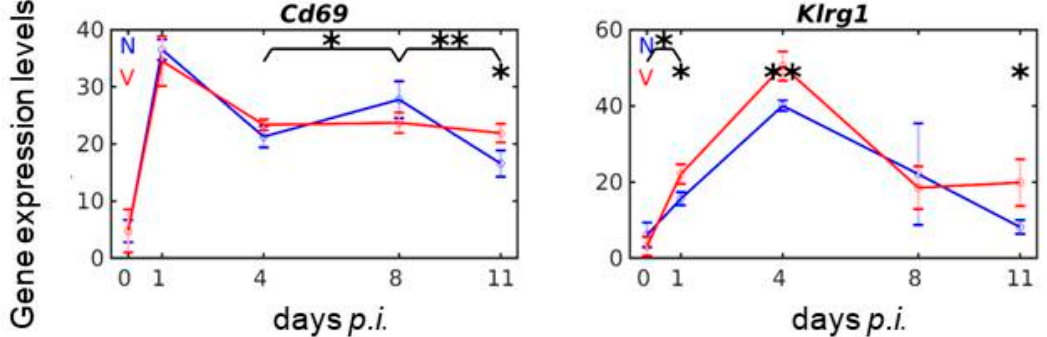
Figure 7. Expression trajectories of Cd69 and Klrg1 in the liver of vaccination-protected and non-protected mice. RNA was isolated from individual livers prepared from vaccination-protected (V, red) and non-vaccinated (N, blue) mice infected with P. chabaudi blood-stage malaria on days 0, 1, 4, 8, and 11 p.i . Gene expression levels in linear scale are plotted as the means of three microarrays ± SD. The number of “*” marks over interval lines connecting two sampling points and over sampling points indicate statistical significance of corresponding intervals and of a given sampling point, respectively, between vaccinated and non-vaccinated mice: * p < 0.05; ** p < 0.01.